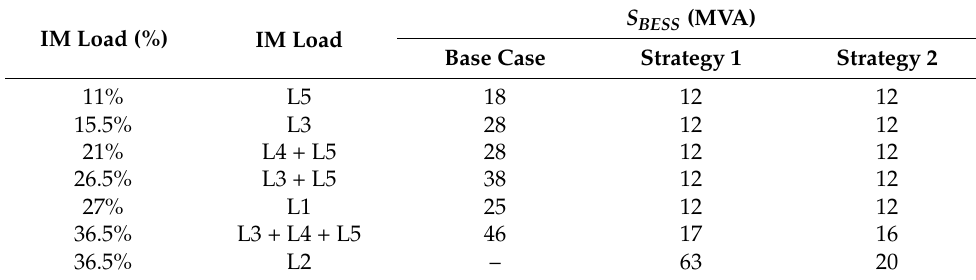
Table 7. Grid-forming BESS power converter sizing vs. IM load percentage.